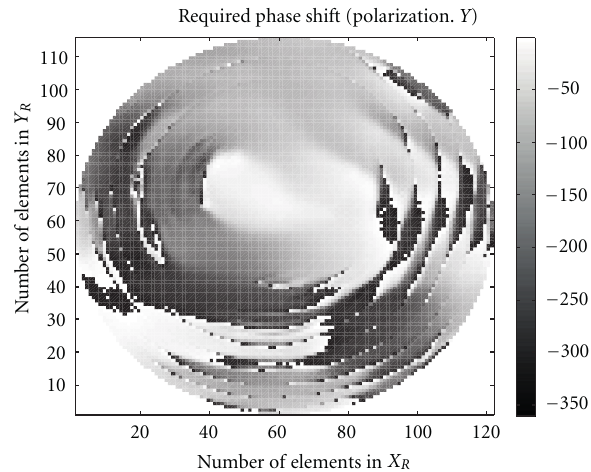
Figure 11: Required phase-shift for a 1.5 m parabolic reflectarray at 11.95 GHz, F /D = 1 . 2